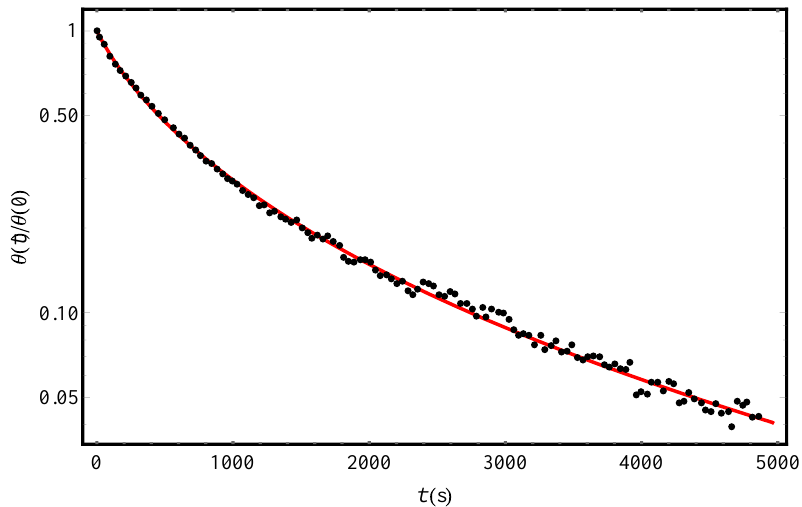
Figure 1. The experimental temporal dependence (points, [9]) of the reduced hydrogen coverage θ ( t )/ θ ( 0 ) of the Si(111)7×7 adsorbent at T = 720 K and the initial condition θ ( 0 ) = 0.14. The solid (red) curve represents the theoretical processing of the data [9] by Equation (12) with parameters Δ = 493 K and τ d = 716